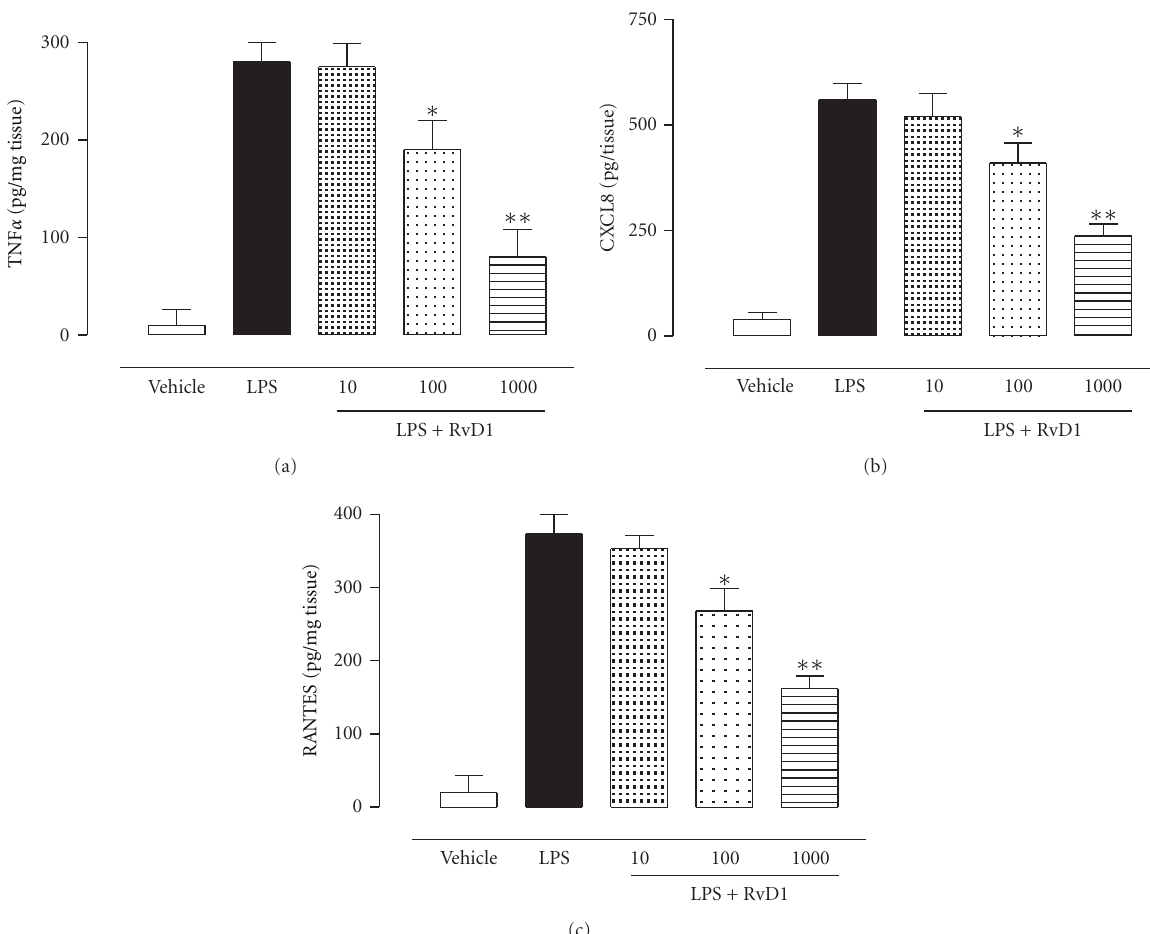
Figure 6: Levels of the cytokine and chemokines TNF-alpha, CXCL8, and RANTES within the homogenate of the uveal tissue. Data expressed as mean ± SE; n = 6 per group. ∗ P < 0 . 05 and ∗∗ P < 0 . 01 compared with LPS-treated